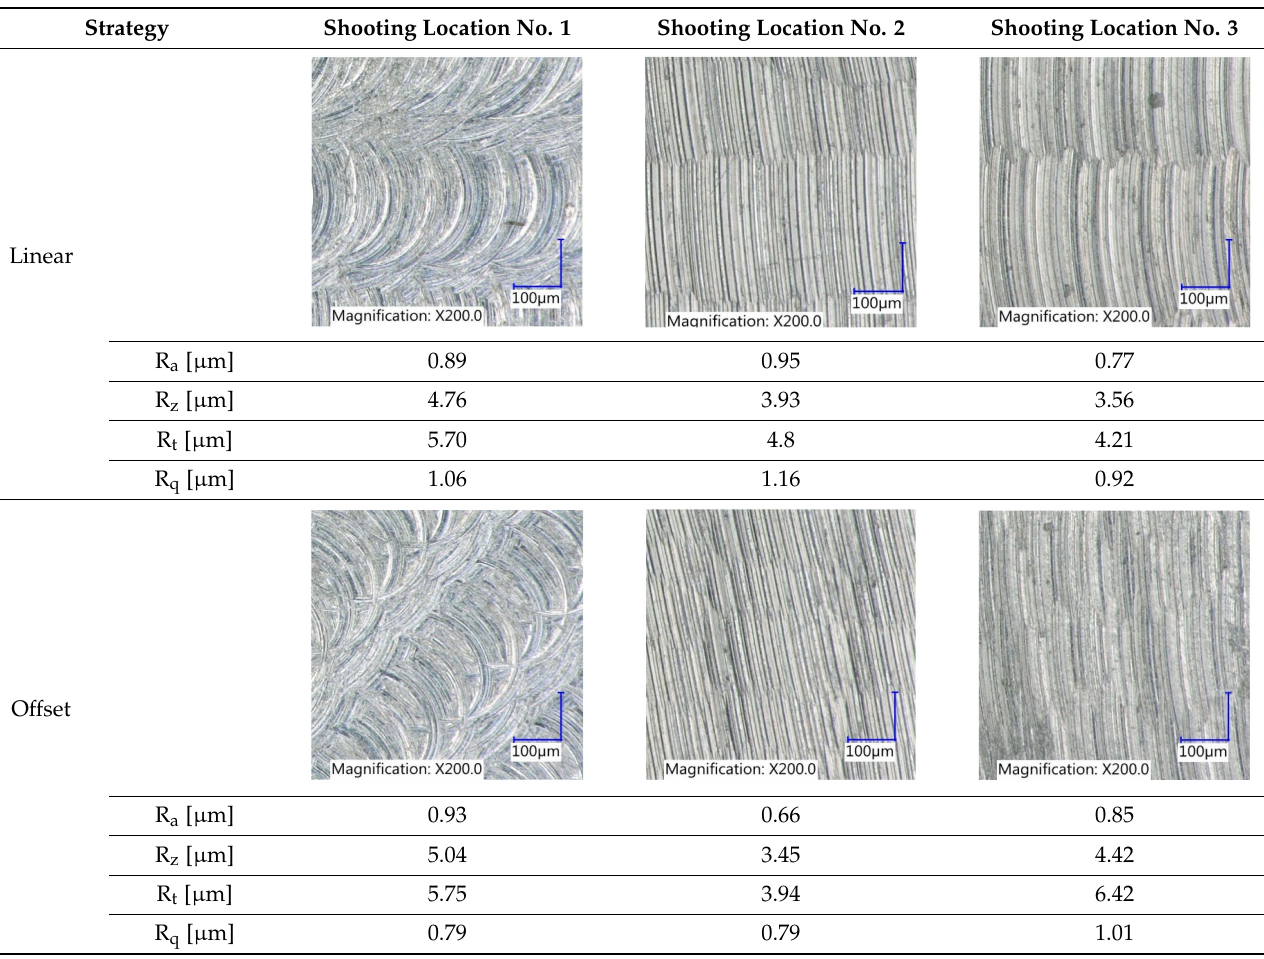
Table 5. Surface texture and surface roughness in 3-axis